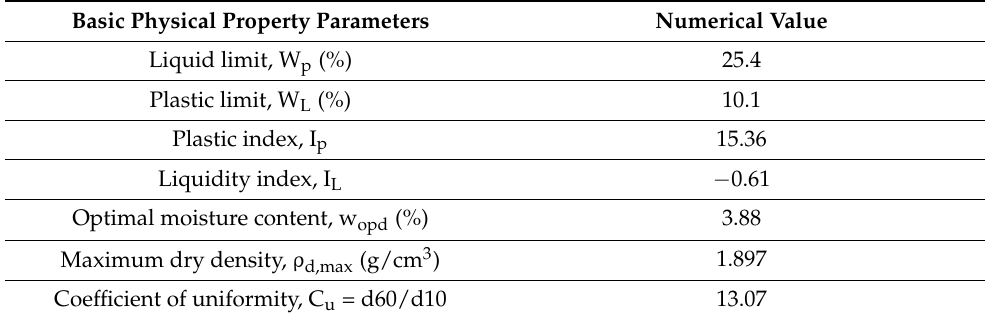
Table 1. List of basic physical property parameters of saline soil.